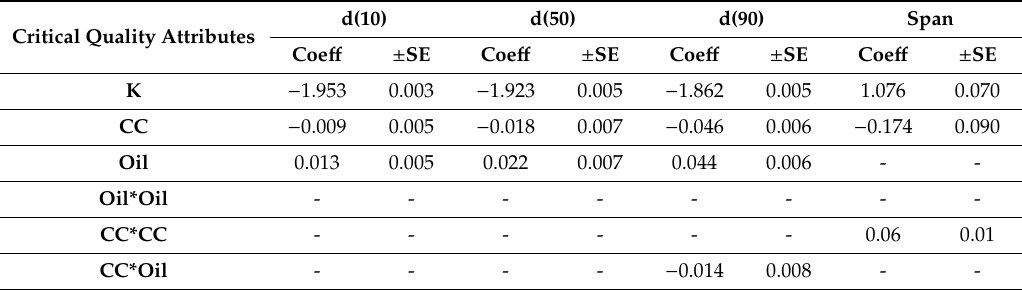
Table 2. Results of regression analysis for measured